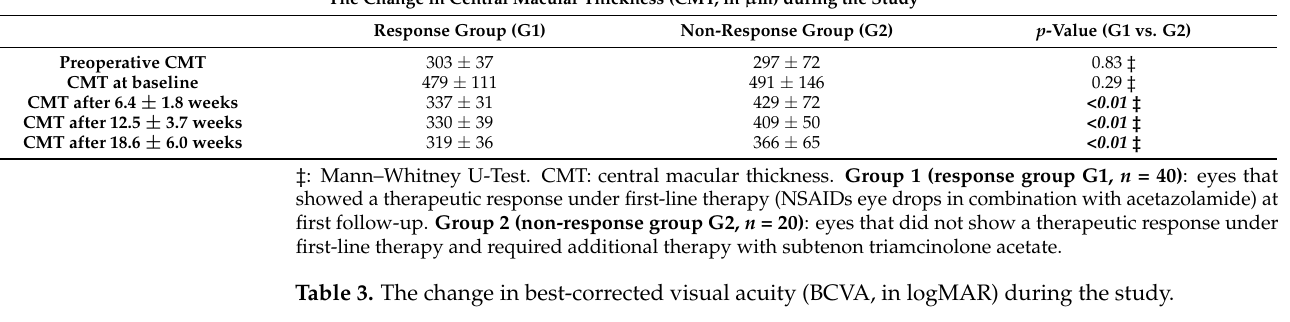
Response Group (G1)